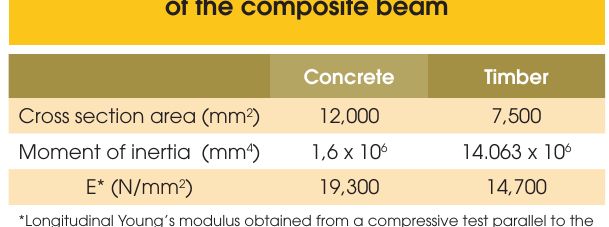
*Longitudinal Young’s modulus obtained from a compressive test parallel to the fiber direction. Connector slip modulus under service loading: K1c (ser) = 15.464 N/mm; Connector spacing (s) = 7.5